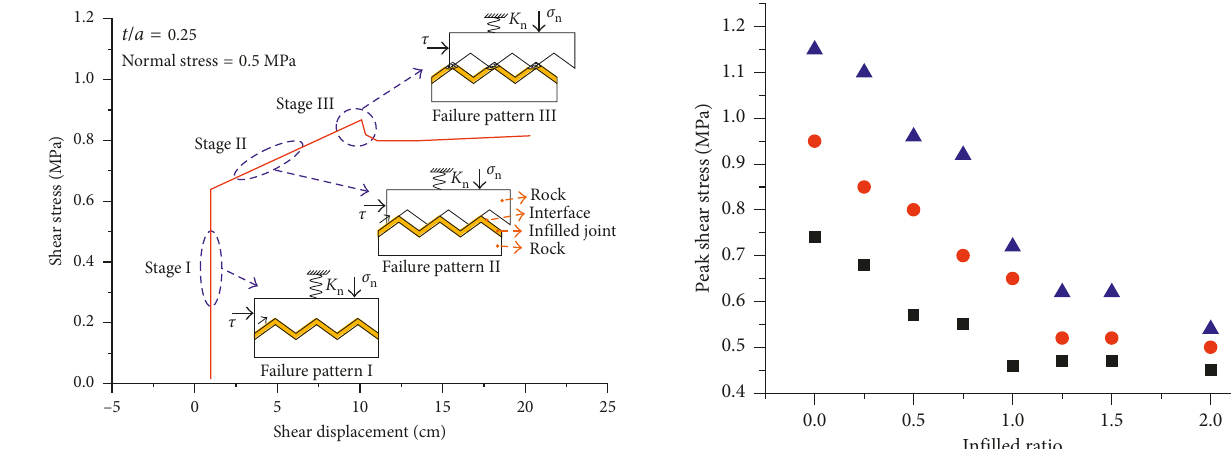
Figure 9: Three different shear failure stages of infilled joints corresponding to different failure modes.